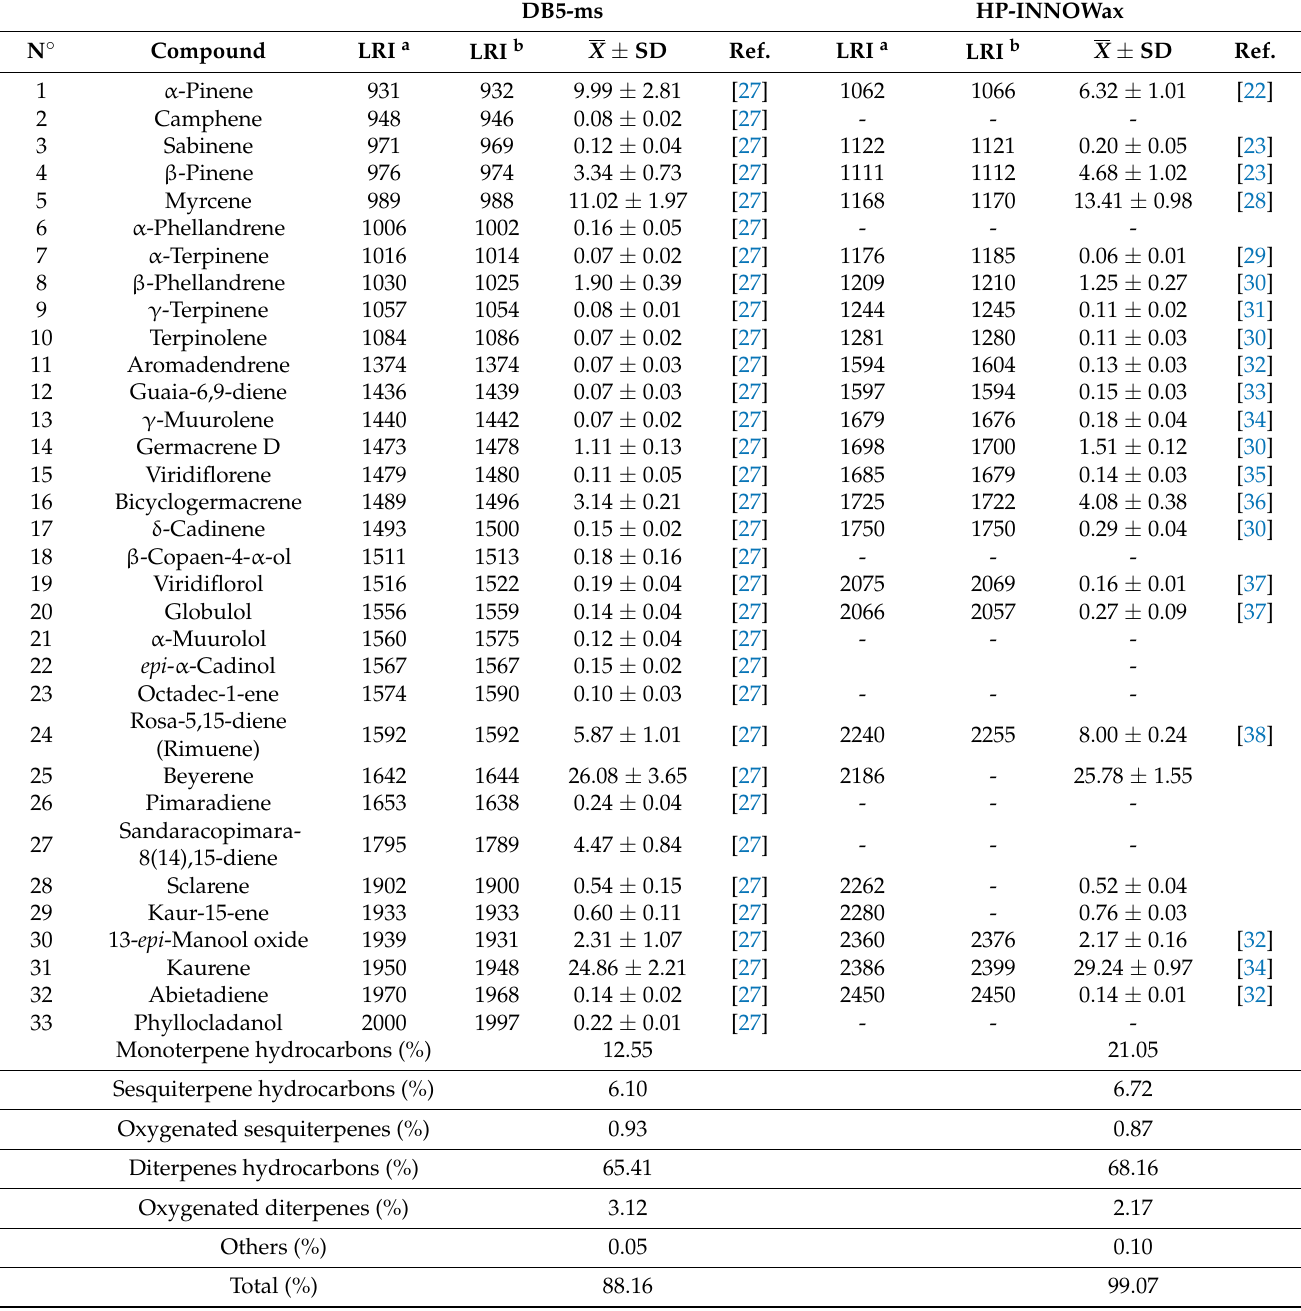
Table 1. Chemical composition of Araucaria brasiliensis leaf essential oil